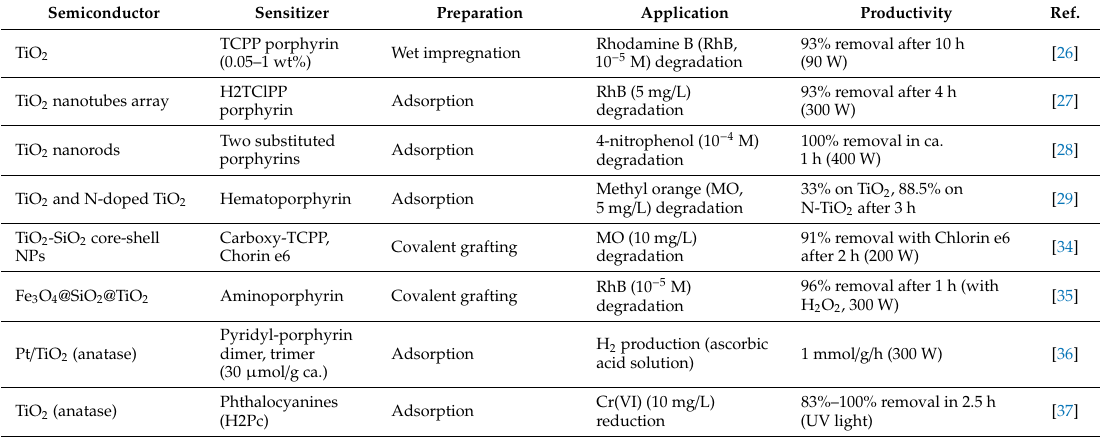
Table 2. Dye-sensitized systems and their photocatalytic activity data under visible irradiation or solar light irradiation. The best results achieved in each work are